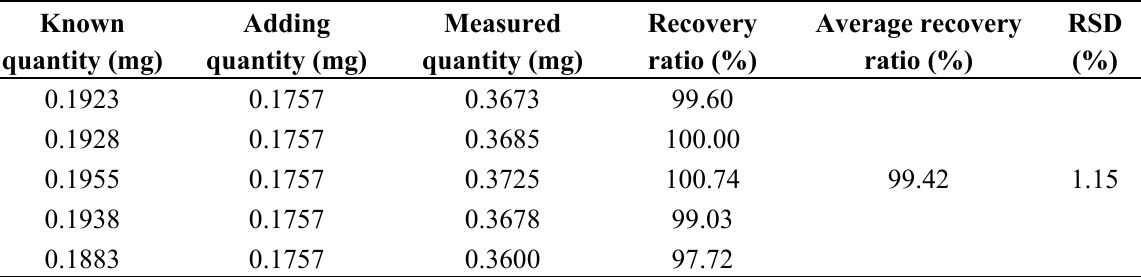
Table 2. Results of Recovery